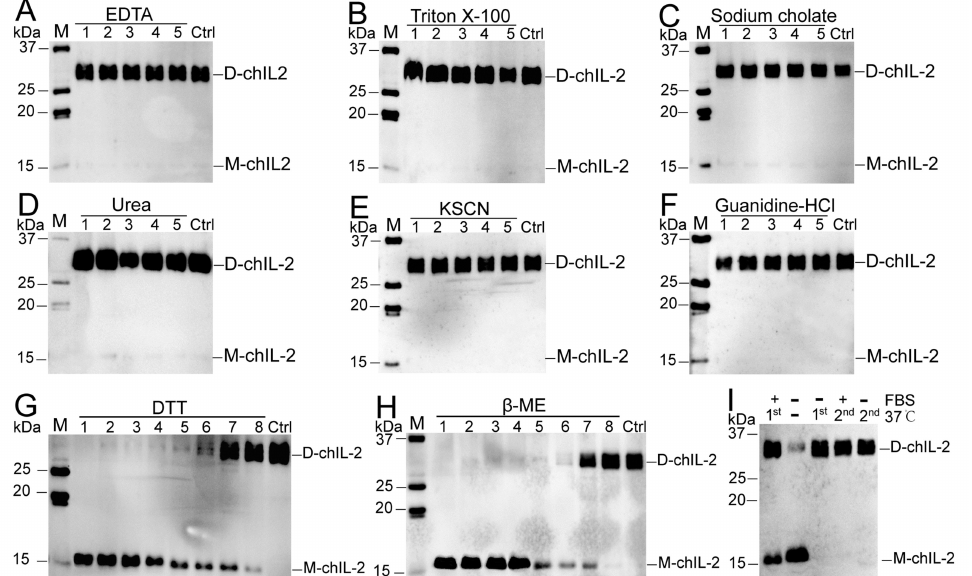
Figure 3. E ff ect of some dissociation reagents on chIL-2 dimer. M, protein standard marker; Ctrl, chIL-2 without treatment with dissociation reagents. Labels 1~5 in ( A – F ), five-fold serial dilution of dissociation reagents. 1~8 in ( G – H ), eight-fold serial dilutions of reducing agents. D-chIL-2, dimeric chIL-2. M-chIL-2, monomeric chIL-2. In ( I ), + , incubation with FBS; − , absence of FBS or incubation at 37 ◦ C. 1st, the first incubation of purified chIL-2 at 37 ◦ C; 2nd, the incubation within FBS post the 1st incubation without FBS at 37 ◦